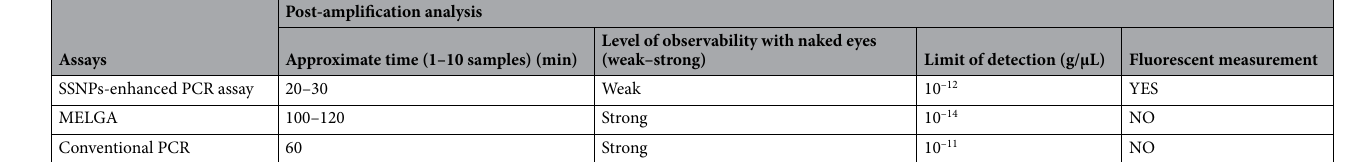
Table 3. Comparison performance of three PCR-based assays in the detection of the LT